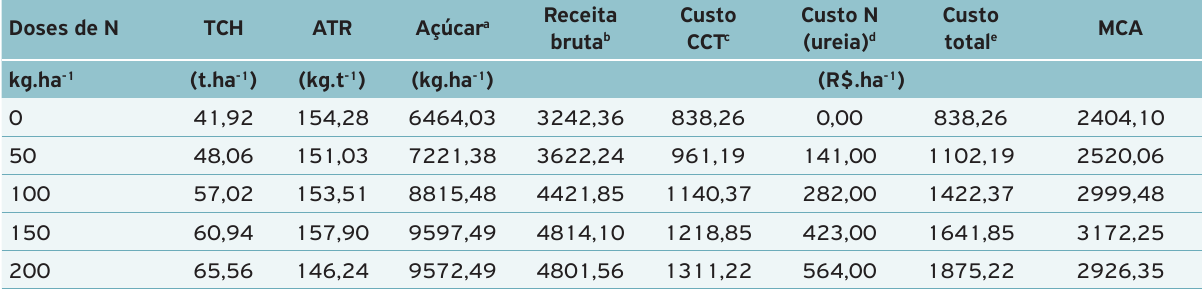
Tabela 2. Rendimento financeiro em função das doses de N-fertilizante aplicadas em cana-de-açúcar (5º corte) irrigada por gotejamento, colhida em agosto de 2011 (315 DAC).